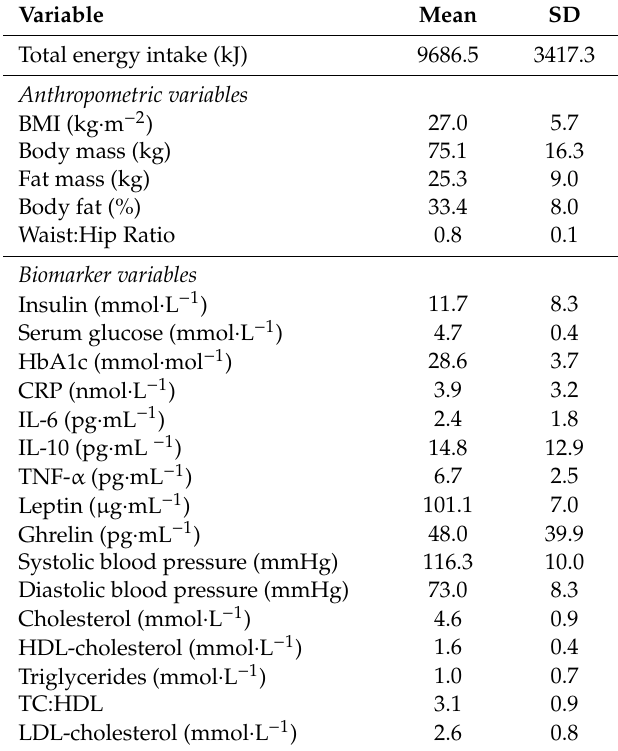
Table 2. Participant anthropometric and biomarker characteristics ( n =